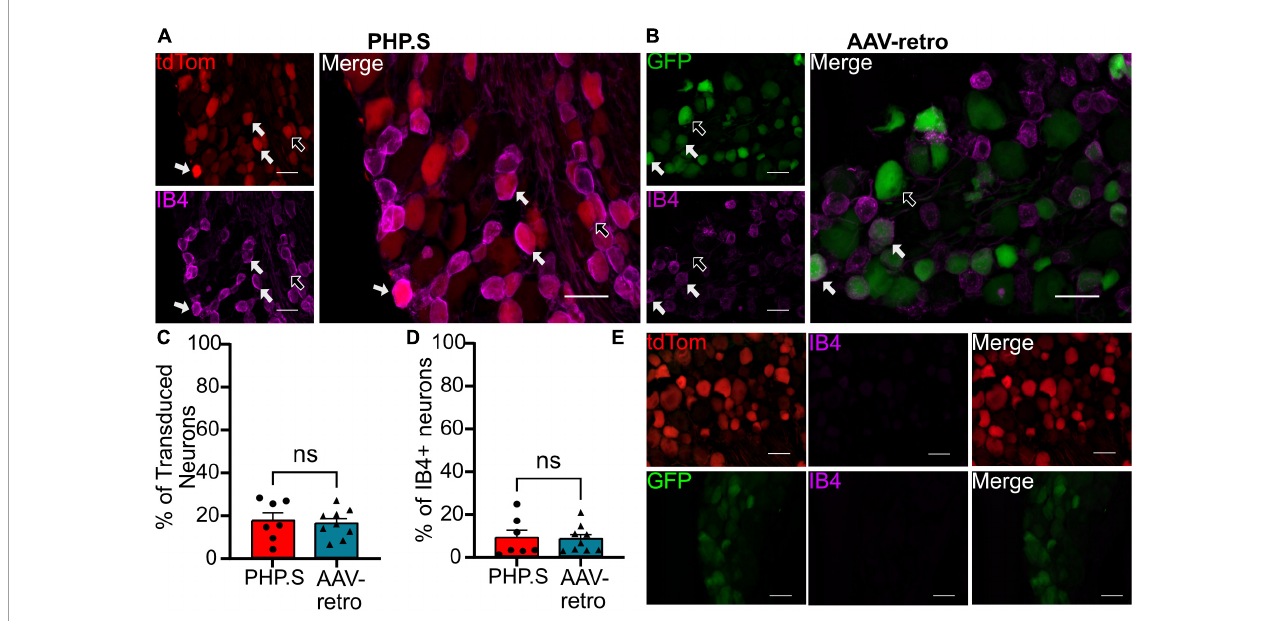
FIGURE7 PHP.S and adeno-associated viruses (AAV)-retro transduce small, non-peptidergic neurons at similar rates. (A) Representative images of tdTomato expression colocalizing with IB4 + neurons in dorsal root ganglia from PHP.S-injected rats (scale bar, 50 µ m). (B) Representative images of GFP expression colocalizing with IB4 + neurons in dorsal root ganglia from AAV-retro-injected rats (scale bar, 50 µ m). (C) Percent of transduced neurons that were IB4 + ( p = 0.7330). (D) Percent of IB4 + neurons that were transduced ( p = 0.8585). (E) Images of dorsal root ganglia tissue from rats injected with PHP.S (top) or AAV-retro (bottom) with no antibody staining in the corresponding fluorophore used for IB4 in experimental tissue. Statistics were performed using the student’s t -test to compare PHP.S ( n = 7) to AAV-retro ( n = 9). White arrows indicate neurons with colocalization.